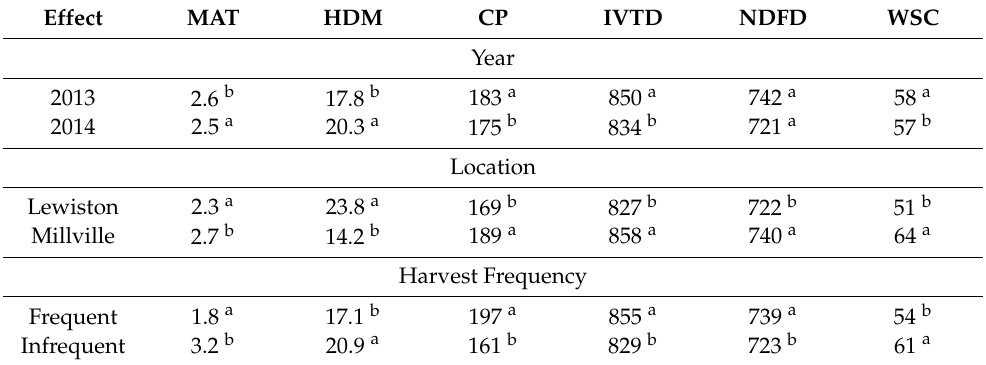
Table 2. Mean trait values corresponding to main effects of year, location, and harvest frequency. Traits were maturity (MAT; 1, very late to 5, very early), herbage dry mass (HDM; Mg ha − 1 ), crude protein (CP; g kg − 1 ), in vitro true digestibility (IVTD; g kg − 1 ), neutral-detergent-fiber digestibility (NDFD; g kg − 1 ), and water-soluble carbohydrates (WSC; g kg − 1 ), measured on 58 orchardgrass families and five commercial cultivars during 2013 and 2014 at Lewiston and Millville, UT under frequent and infrequent harvest intervals. Values, in the same column and for the same effect, followed by different letters differ at least at the 5% α level based on least-significant